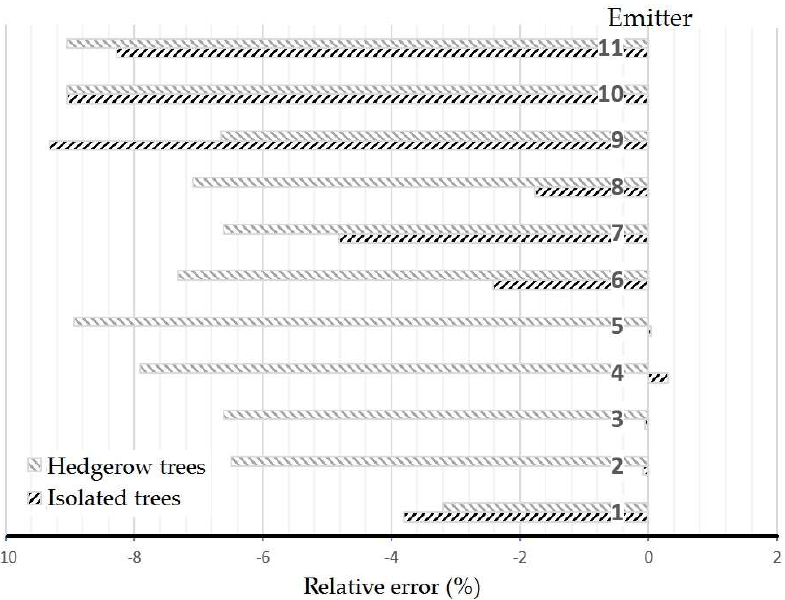
Figure 11. Mean values of the relative error of each emitters’ sensor.